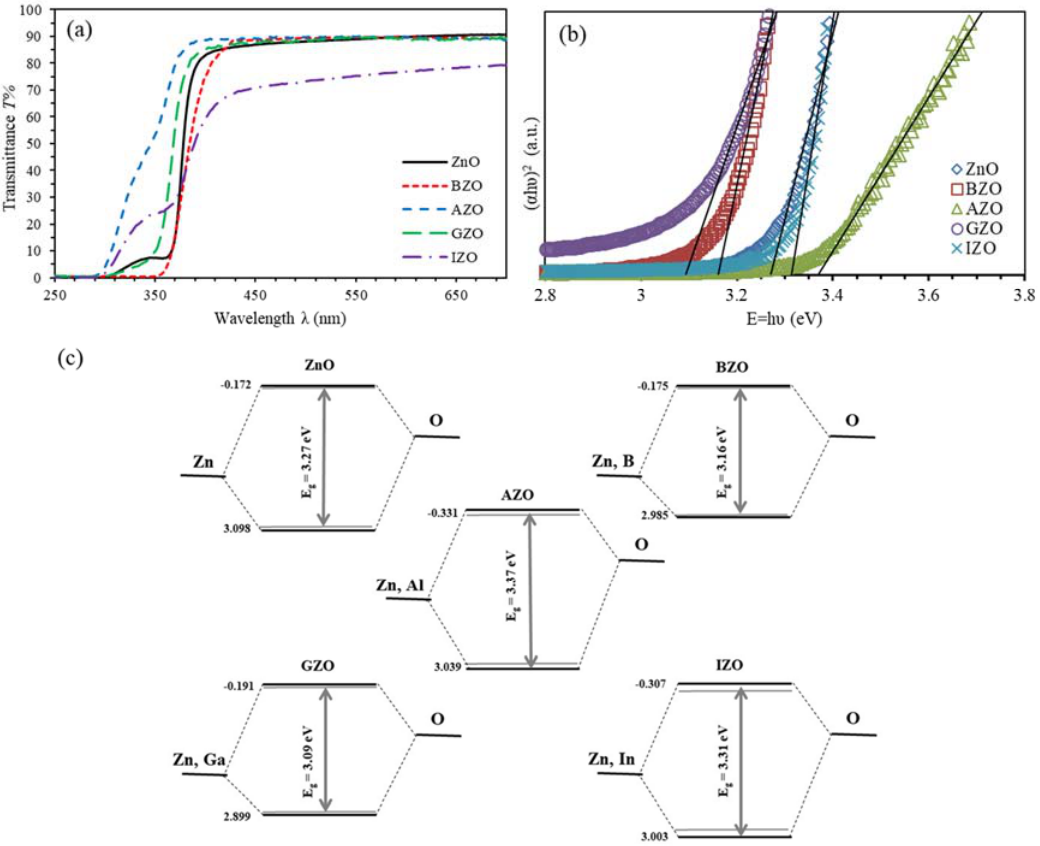
Figure 1. ( a ) Transmittance spectra, ( b ) band gap energy, and ( c ) schematic images and binding structures of undoped ZnO and group III elements (B, Al, Ga and In)-doped ZnO thin films at a doping level of 3%.